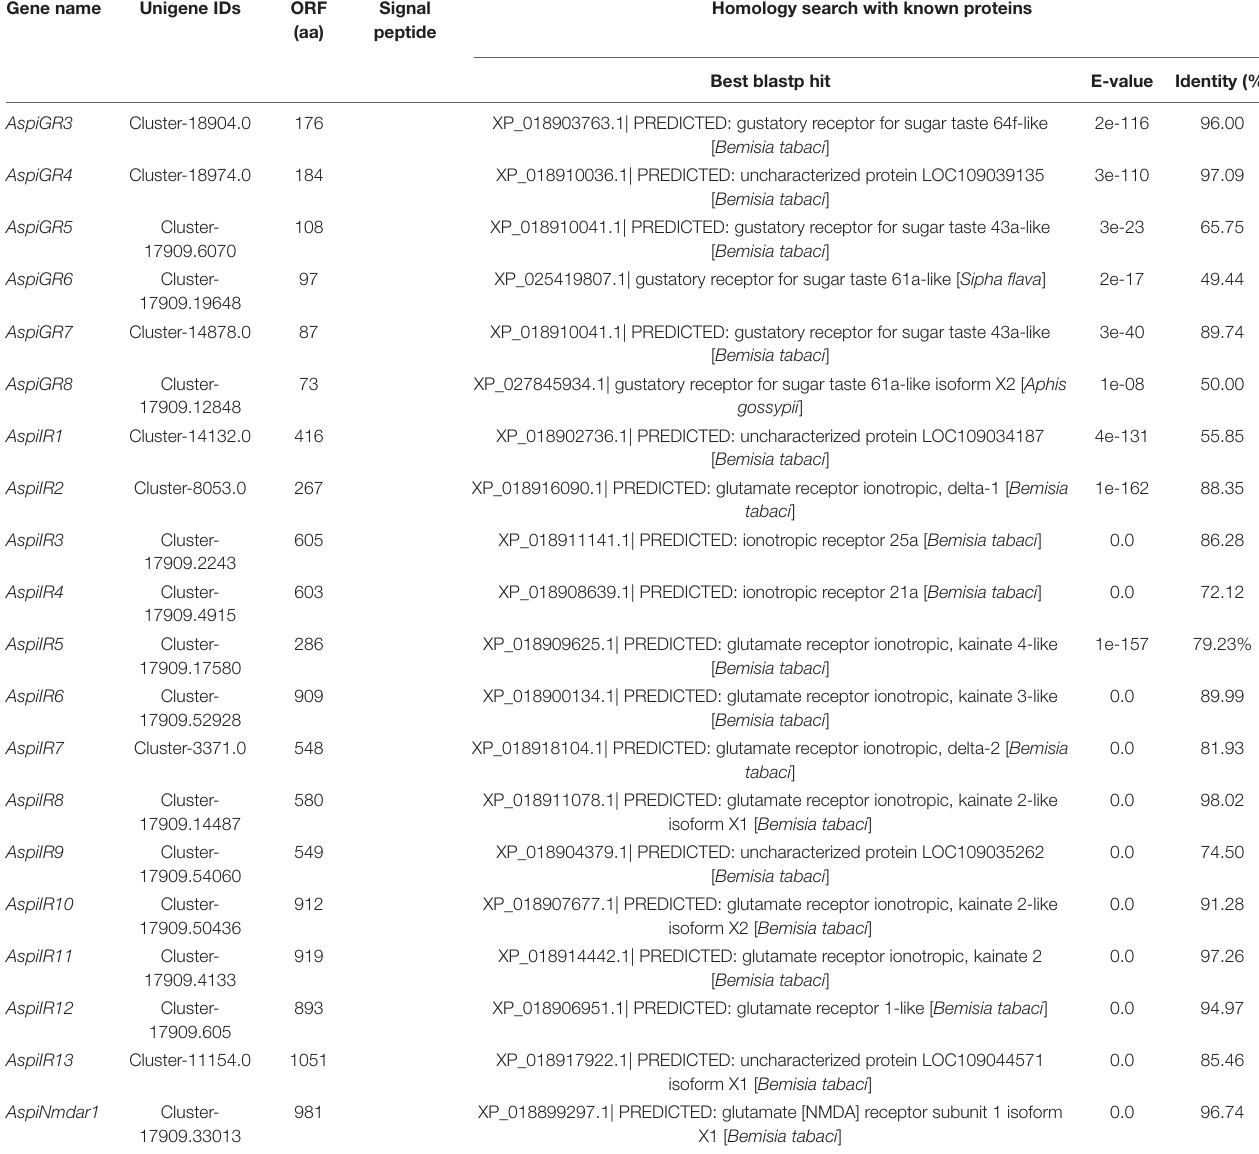
sterilized ultra-pure grade H 2 O. The cycling conditions were 5 s and 55 ◦ C for 30 s. Three technical and three biological replicates were used for each sample. Relative quantification was performed using the Comparative 2 − (cid:49)(cid:49) CT method (Livak and Schmittgen, 2001). Transcription levels of these chemosensory genes were normalized by reference gene RPS28 (Kang et al., 2017a; Kong et al., 2021). Heatmaps of chemosensory genes were Differences of selected chemosensory genes between male and female were subjected to Student’s t -test ( P < 0.05), while one- way analysis of variance (ANOVA) followed by separation